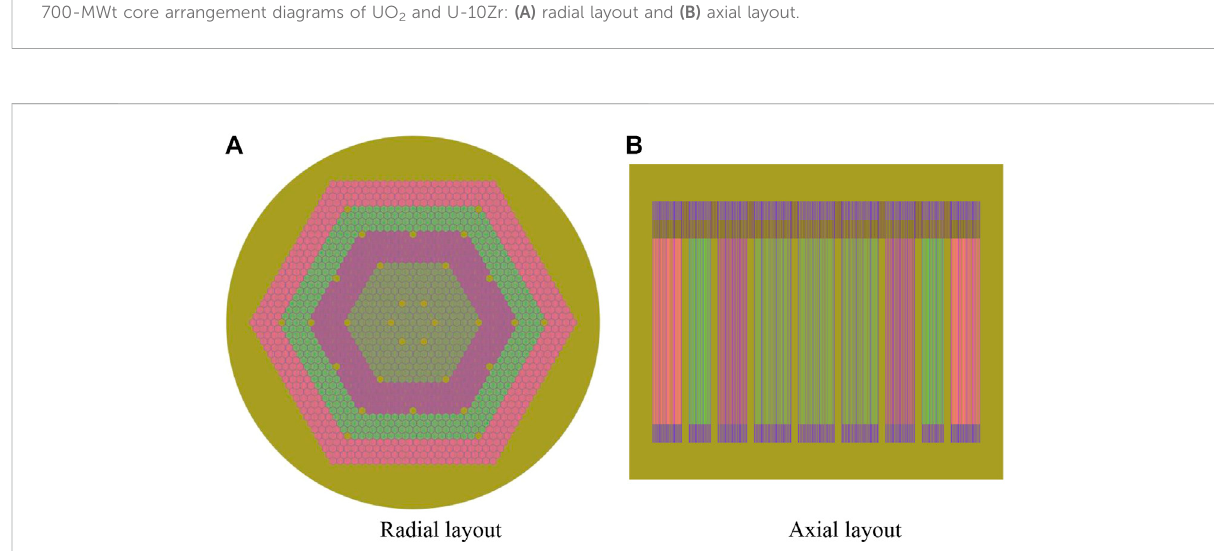
FIGURE 6 1000-MWt core arrangement diagrams of UO 2 and U-10Zr: (A) radial layout and (B) axial